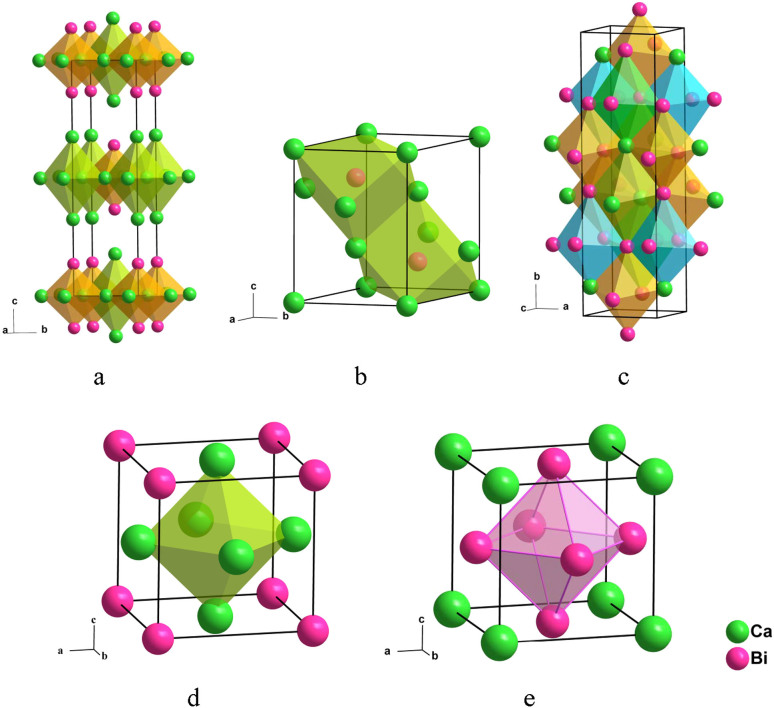
Crystal structures for (a): tI12-Ca2Bi, (b): hP5-Ca3Bi2, (c): oS12-CaBi2, (d): cF4-Ca3Bi and (e): cF4-CaBi3.